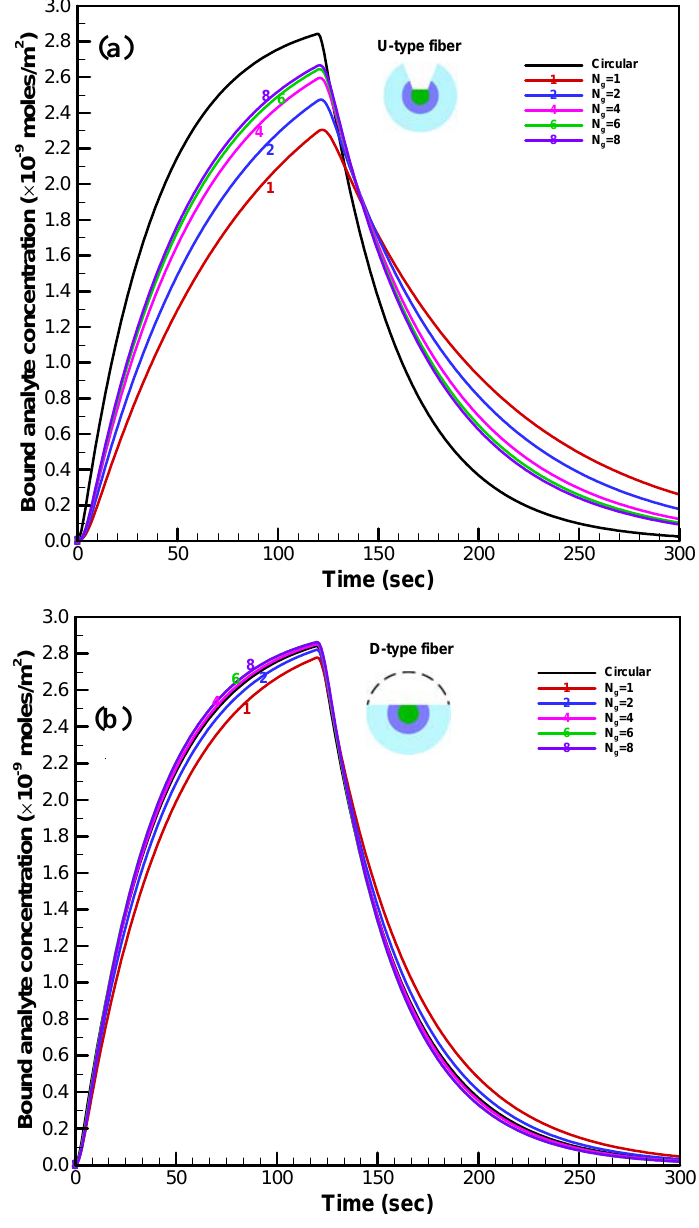
Figure 5. Simulated time histories for the average concentration of bound analyte on (a) the U-type and (b) D type fibers. (a) U-type fiber. (b) D-type